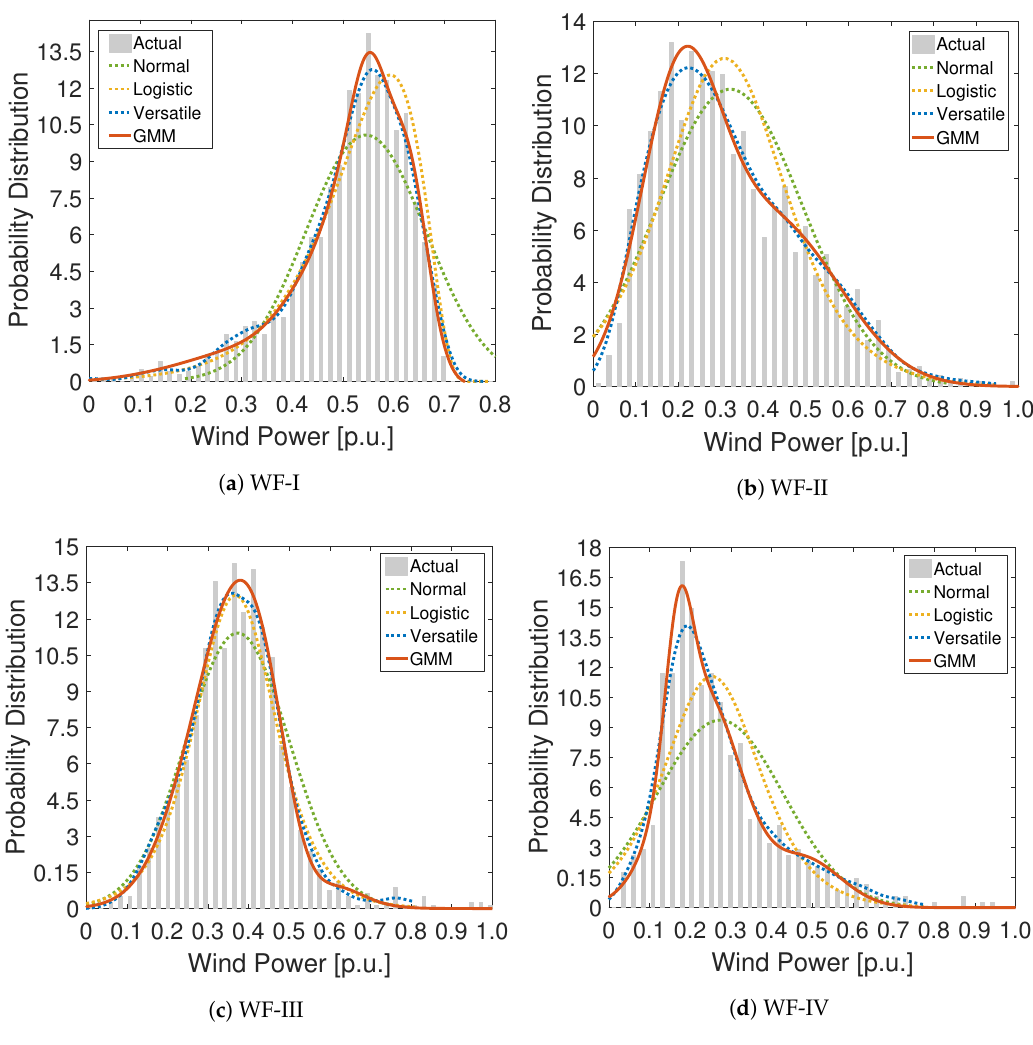
Figure 3. PDF comparisons of four wind farms; ( a ) WF-I; ( b ) WF-II; ( c ) WF-III; ( d ) WF-IV. As shown in Table 3, the metrics of the GMM distribution are the smallest, compared with those of the normal, logistic and versatile distributions. Taking the MAE metrics as an example, the normal distribution presents the metrics values with the range 0.11 ∼ 0.17; the logistic distribution presents the metrics values with the range 0.08 ∼ 0.12; the versatile distribution presents the metrics values with the range 0.04 ∼ 0.08; and the GMM distribution presents the metrics values with the smallest range 0.01 ∼